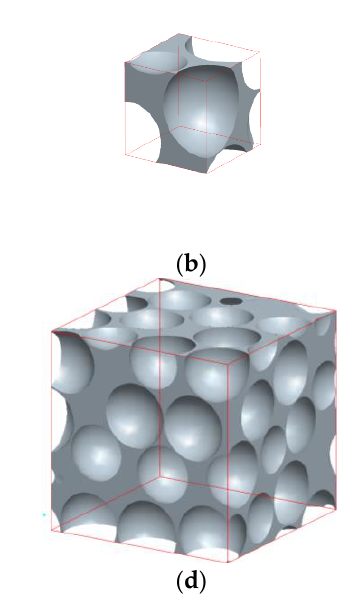
Figure 2. Randomly packed bed and random packing units: ( a ) randomly packed bed (10 d p × 10 d p ×